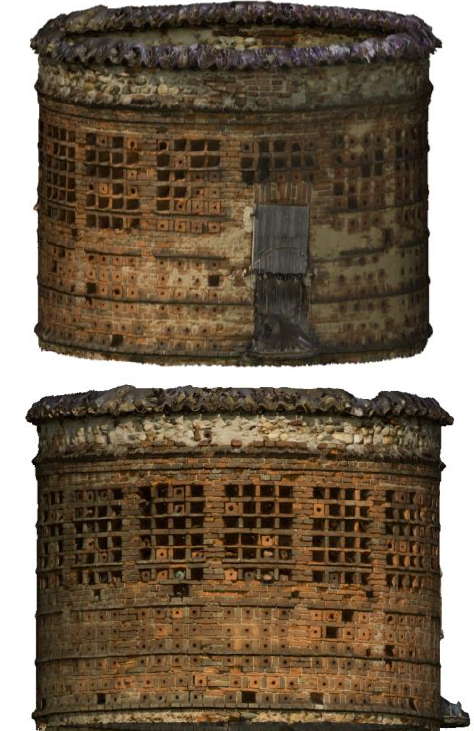
Figure 8. 3D mesh without RGB information; fitting to the cylindrical volume; 3D model analysis by surface comparison Figure 7. Very high detailed 3D textured model from a South between the photogrammetric mesh and the best fitting view and a West view.